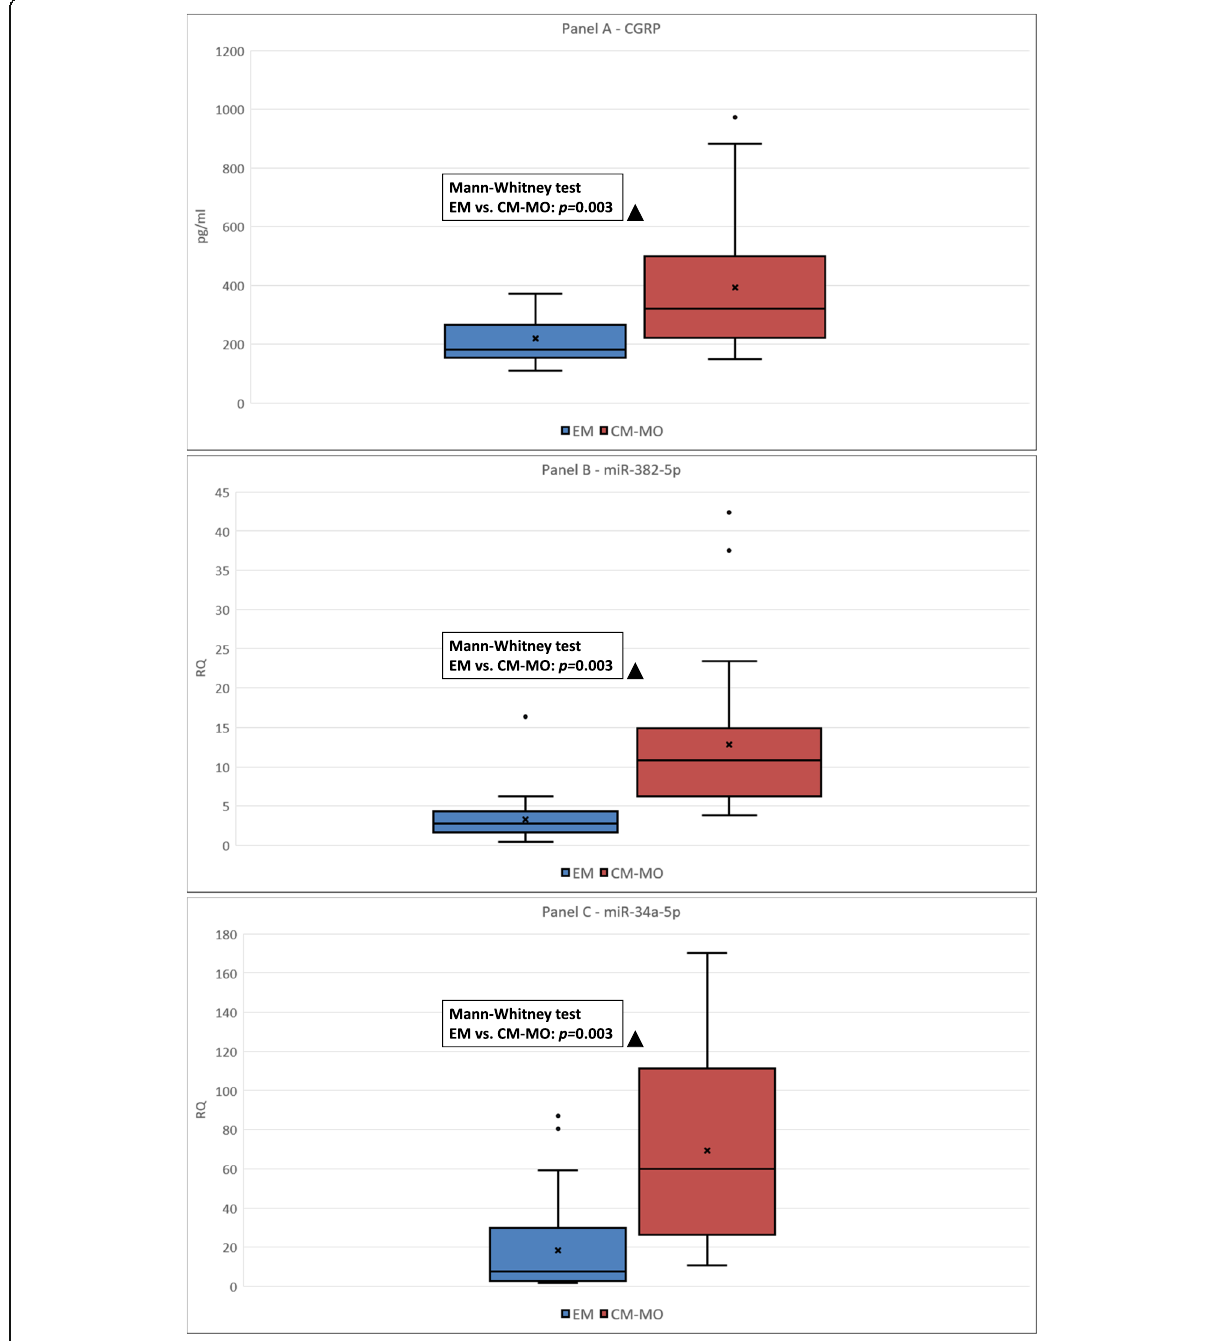
Fig. 1 CGRP plasma levels, and miR-382-5p and miR-34a-5p expression in peripheral blood mononuclear cells of subjects with episodic migraine and chronic migraine with medication overuse. EM: episodic migraine ( n = 27); CM-MO: chronic migraine with medication overuse ( n = 28 ). Panel a : comparison of CGRP between EM and CM-MO subjects. Panel b : comparison of miR-382-5p between EM and CM-MO subjects. Panel c : comparison of miR-34a-5p between EM and CM-MO subjects. Box-plots: the distance between the top and bottom of the box represents the interquartile range (IQR: 25th percentile to 75th percentile). The line inside the box represents the median value, while the cross inside the box represents the mean value. The upper and lower whiskers represent the maximum and minimum values respectively (outliers excluded). Black dots above the upper whiskers represent possible outliers (outliers are statistically defined as values outside the 75th percentile + 1.5*IQR). Δ : EM vs. CM-MOH: p < 0.005 (Mann-Whitney Test with post-hoc Bonferroni ’ s correction). RQ: Relative quantification: 2 −ΔΔ Ct = 2 − ( Δ Ct gene −Δ Ct housekeeping gene) ; Ct: cycle